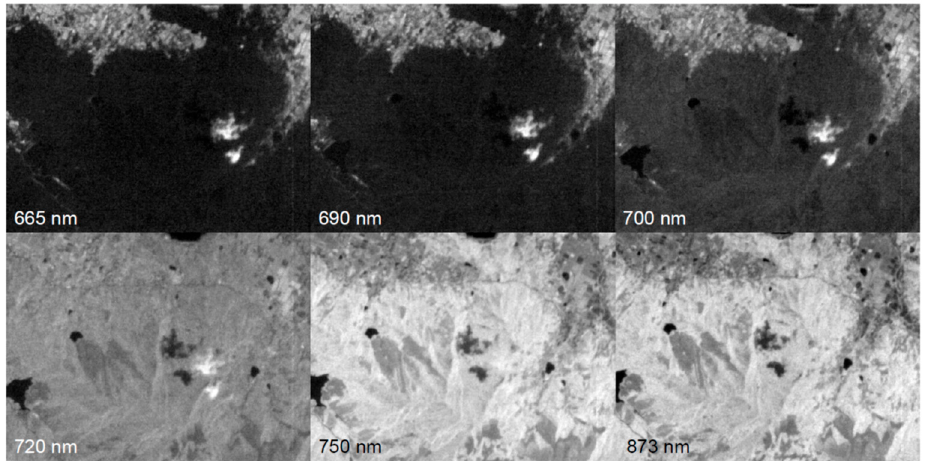
Figure 6. Multispectral images of Shimonoseki City, Yamaguchi Prefecture, Japan, acquired on 29 May 2015.